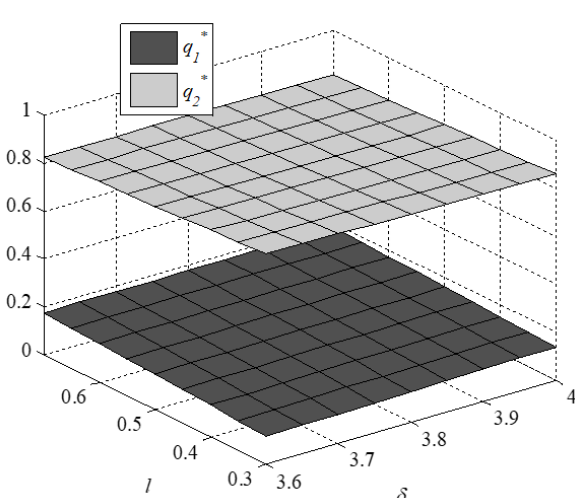
Figure 3. Changes in market demand.